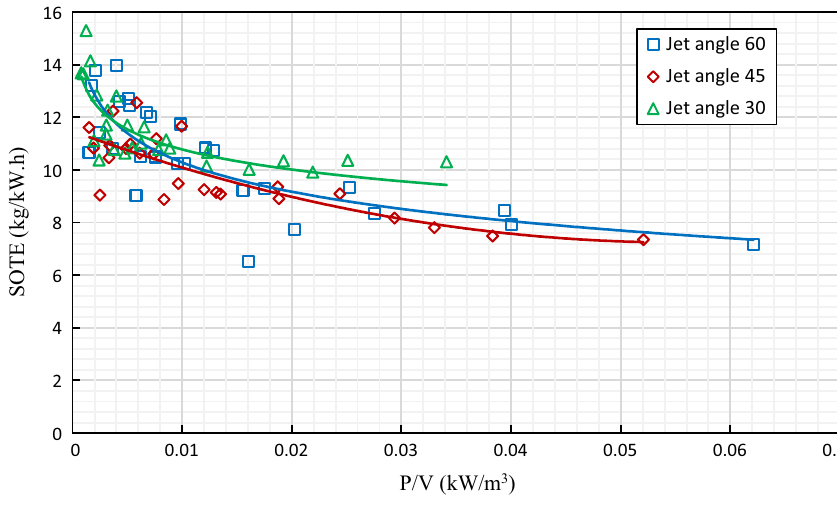
Fig. 7 Variation of SOTE with jet power per unit volume ( P / V ) indicating the effect of jet angle (in